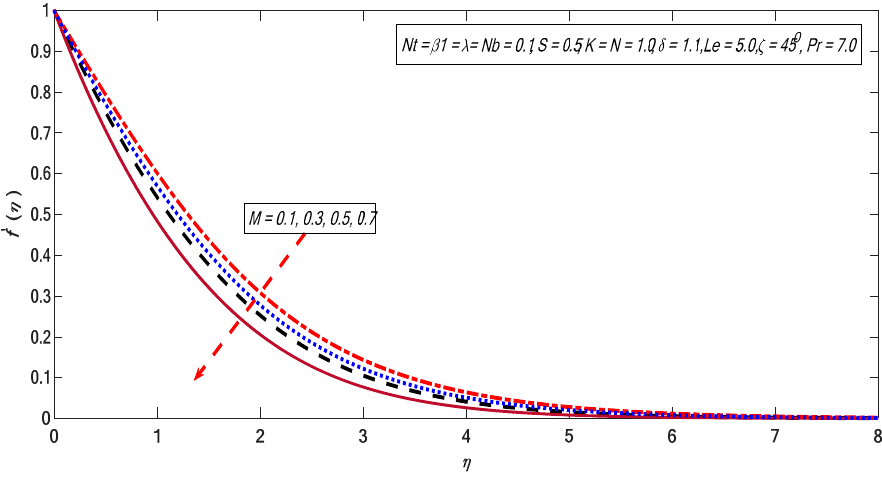
Figure 2. Variations in velocity profile for several values of 𝑀 .